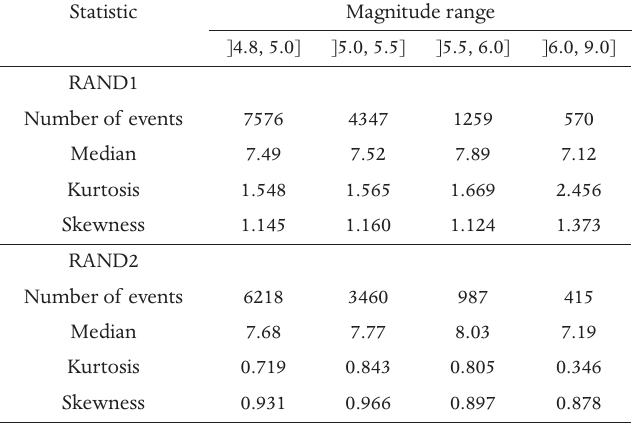
Table 1. Statistics relating to the maximum intensities A of perturbations (see text for explanations) according to the RAND1 and RAND2 random databases with events occurring everywhere.